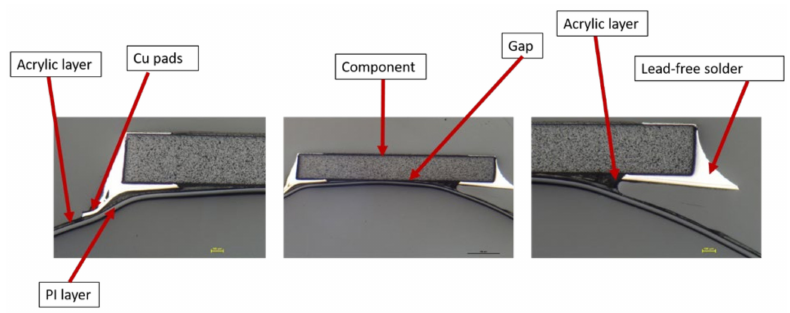
Figure 21. Cross-section images for curved